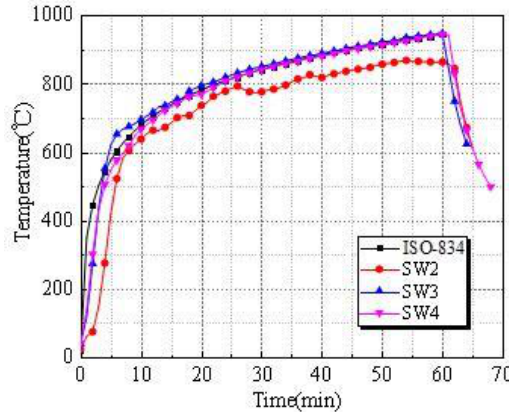
Figure 10. Comparison of measured temperature–time curves in furnace and ISO 834 standard curve.